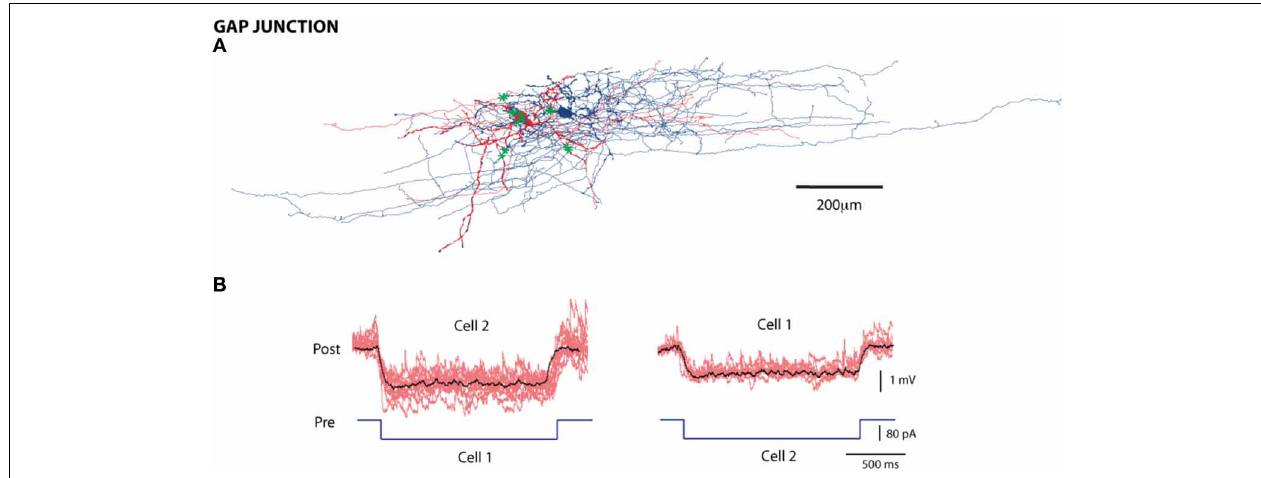
FIGURE 4 | Gap Junctions between L1 cells. (A) Reconstruction of a pair of cells connected by gap junctions; green asterisks are the contact points. Scale bar = 200 μ m (B) An example of a gap